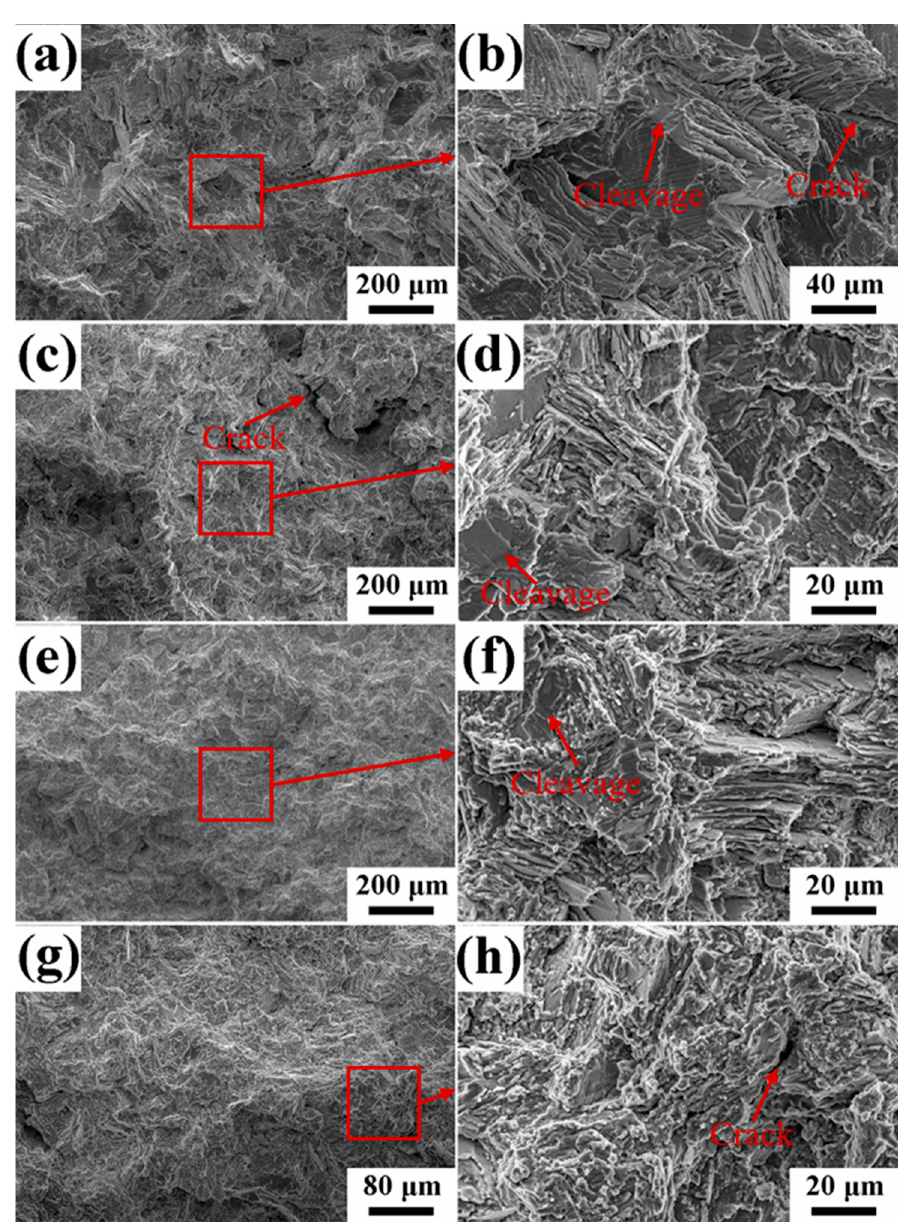
Figure 10. Tensile fracture morphology at 900 °C: ( a,b ) 0 at%; ( c,d ) 0.05 at%; ( e,f ) 0.10 at%; ( g,h ) 0.20 at%.